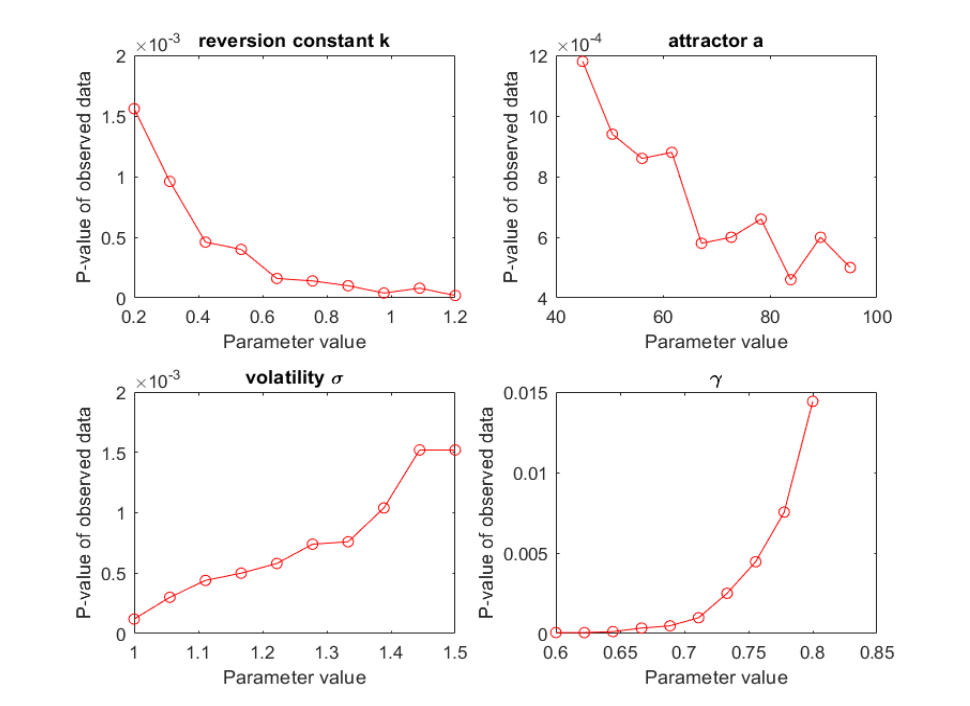
Figure 3. Marginal sensitivity of the p-value to changes in the four parameter values. The parameters varied between their respective 10% and 90% percentiles. It turns out that the p -value remained highly significant over these